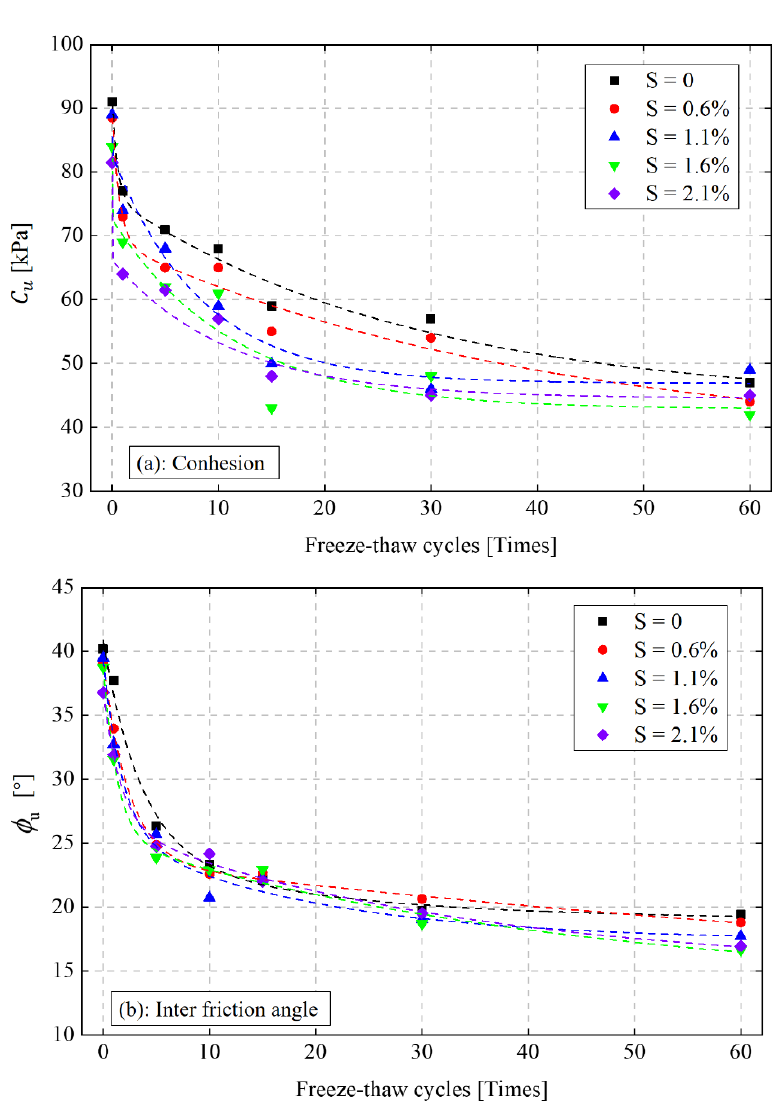
Figure 10. Cohesion and inter-friction angle versus FTCs for the specimens with different salt con- tents. Table 7. Equation of trendlines of cohesion versus FTCs at different salt contents.